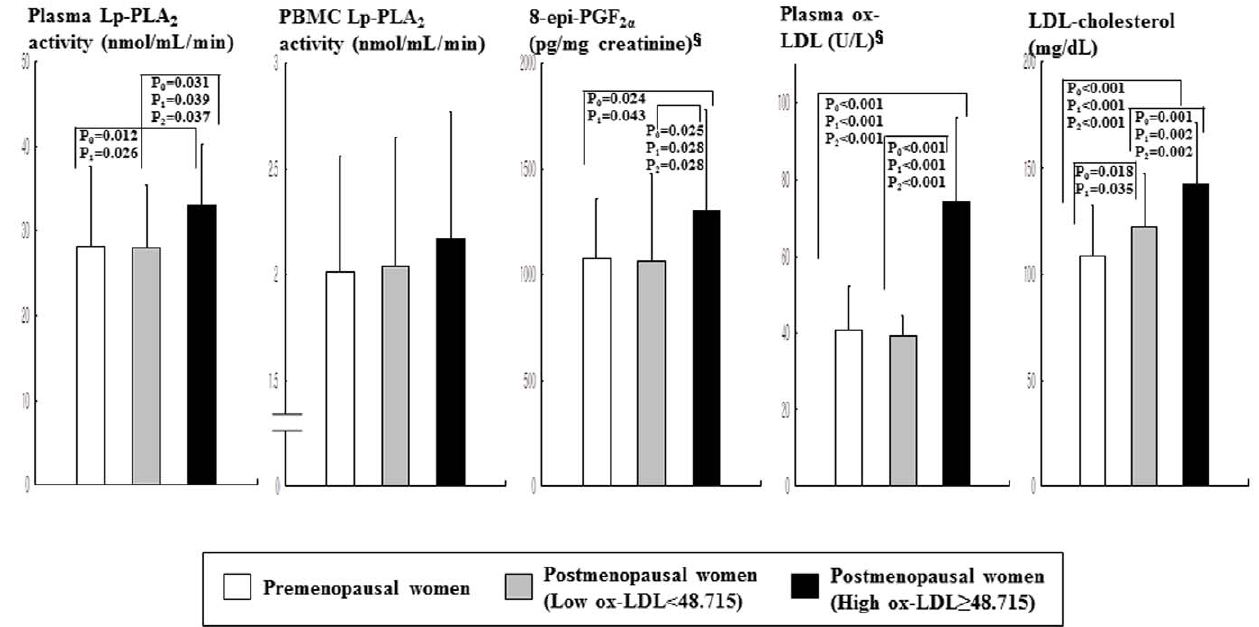
Figure 2. Lp-PLA 2 activity in plasma and supernatants from nonstimulated PBMC cultures and oxidative stress markers according to menopausal status and plasma ox-LDL levels (below or above the median level of 48.715 U/L). Data are means 6 SD. 1 tested by log- transformed. P 0 : unadjusted, tested by one-way ANOVA with Bonferroni method P 1 : adjusted for BMI and alcohol consumption, tested by general linear model (GLM) analysis. P 2 : adjusted for age, BMI, and alcohol consumption, tested by GLM analysis.